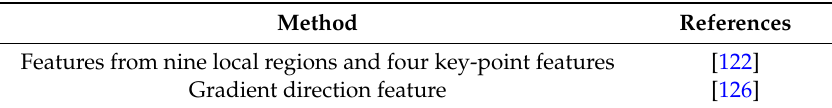
Figure 19. Example of key-point-based feature extraction in the serial number recognition process flow. Table 12. Methods for feature extraction in the serial number recognition process step.